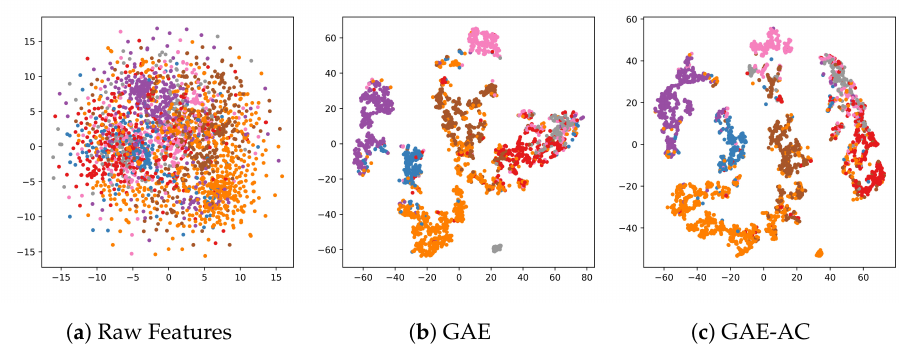
Figure 4. Two-dimensional (2D) visualization results on Cora .